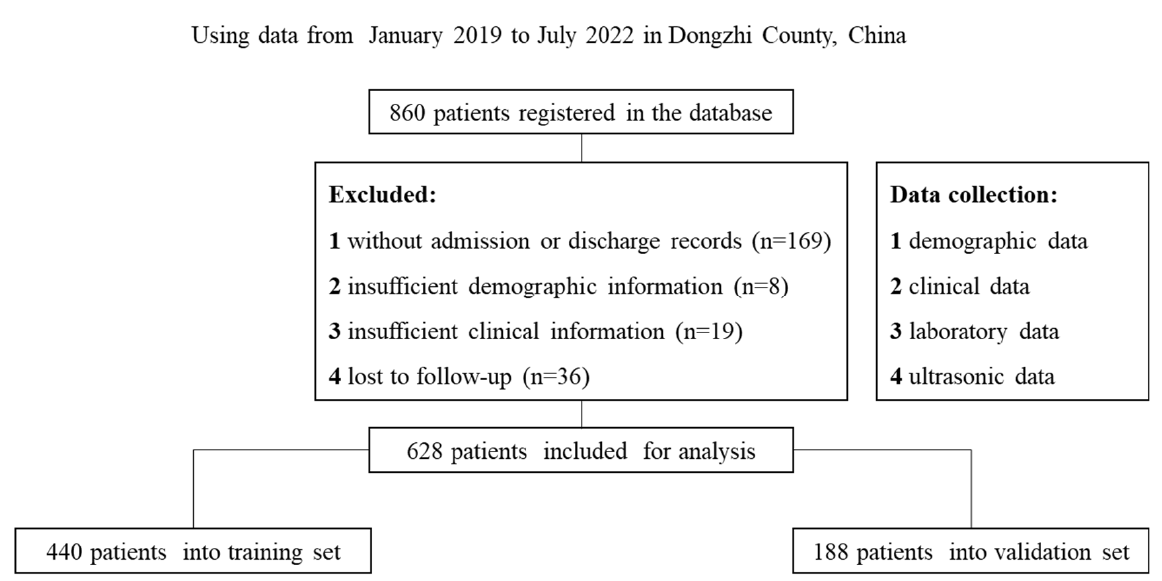
Figure 1. The flowchart illustrates this study’s procedure, including the study population selection, data collection, and the basis of the training and internal validation sets. Table 1. Characteristics of patients with advanced schistosomiasis in this study.